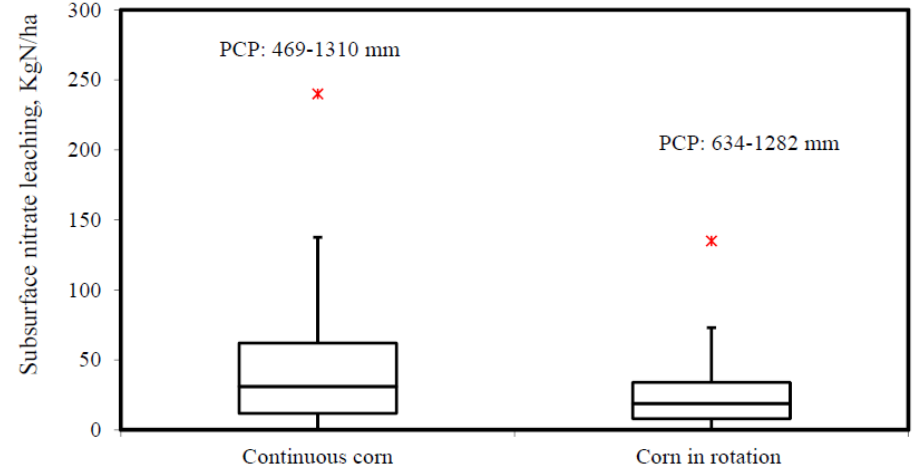
Figure 3. Subsurface nitrate leaching in continuous corn and corn in rotation within various ranges of precipitation (twenty nine and sixteen journal articles were used for continuous corn and corn in rotation, respectively). PCP: Precipitation.